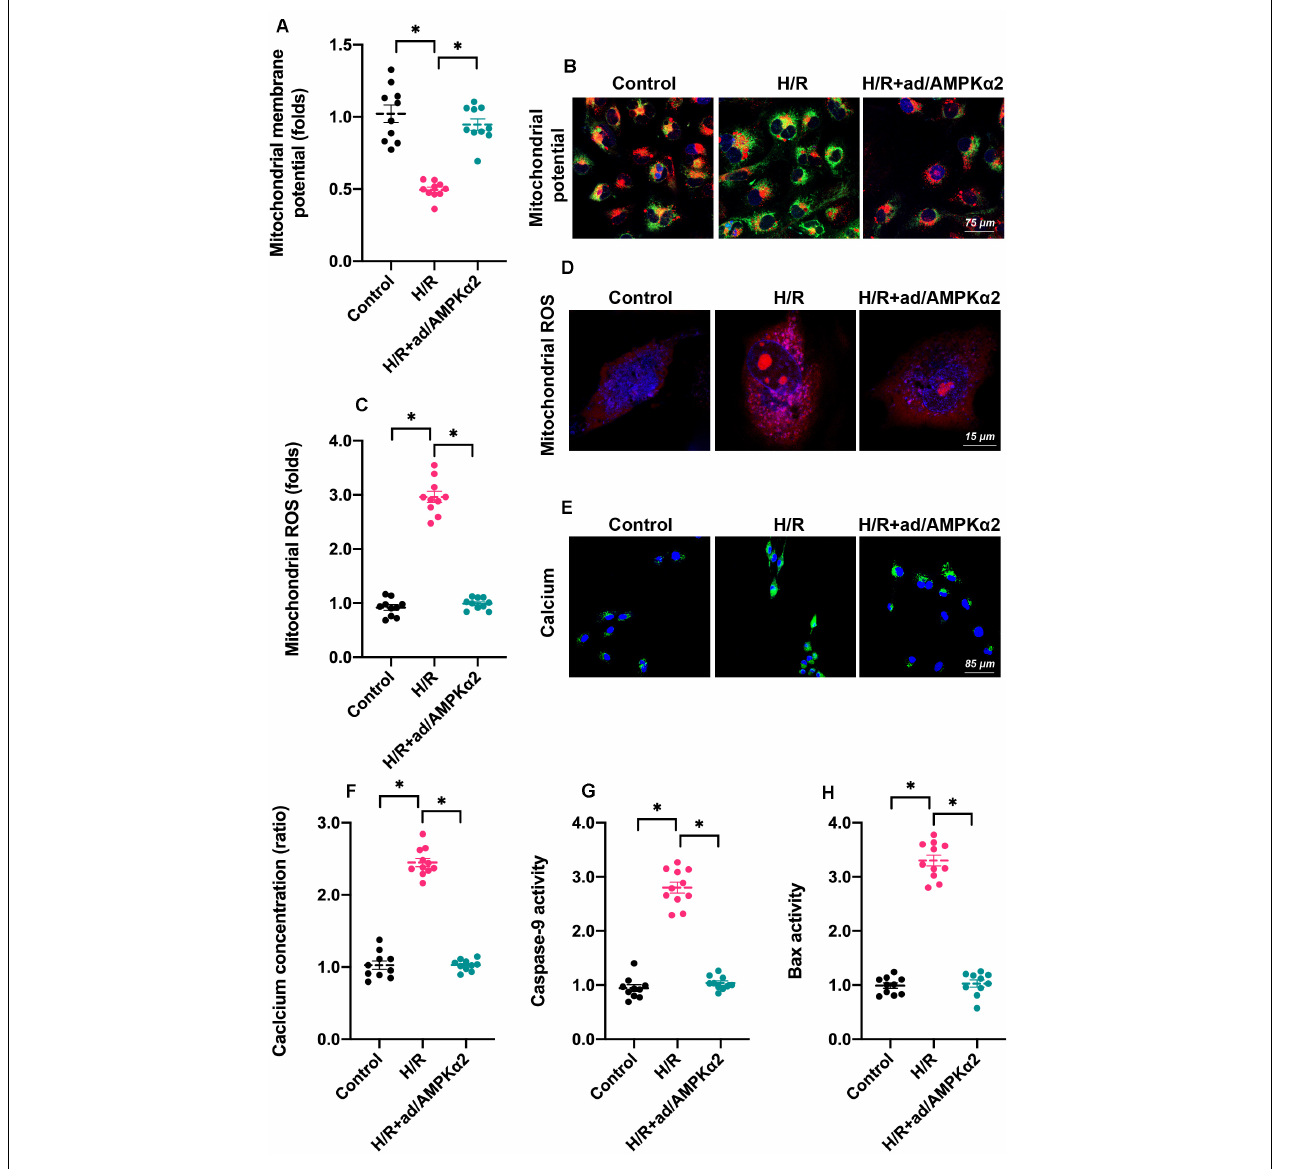
FIGURE 2 | AMPK2 α overexpression sustains mitochondrial homeostasis. Adenovirus loaded with AMPK α 2 were transfected into cardiomyocytes before H/R injury. (A,B) Mitochondrial membrane potential was measured through JC-1 probe relative fluorescence intensity in H/R cardiomyocytes. (C,D) Intracellular ROS were determined through immunofluorescence. (E,F) H/R-mediated calcium overload was determined through immunofluorescence. (G,H) ELISA was used to measure the activities of caspase-9 and Bax in cardiomyocytes treated with H/R injury. The data represent the mean ± SEM. P <